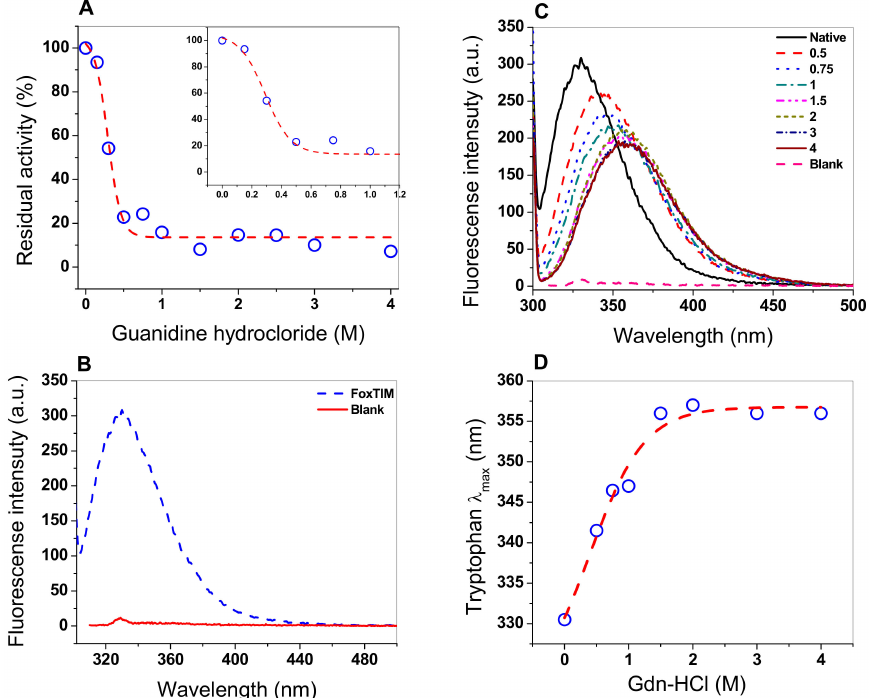
Figure 8. Stability analysis of FoxTPI protein in the presence of Gdn-HCl. ( A ) e ff ect of the Gdn-HCl on the activity of FoxTPI; ( B ) fluorescence emission spectra of the native FoxTPI enzyme; ( C )